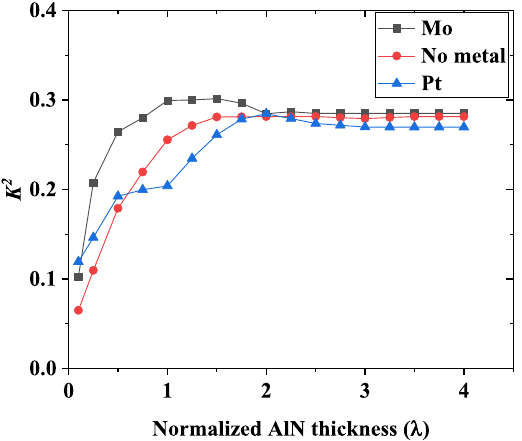
Figure 4. K 2 for the different metal layer materials as a function of normalized AlN